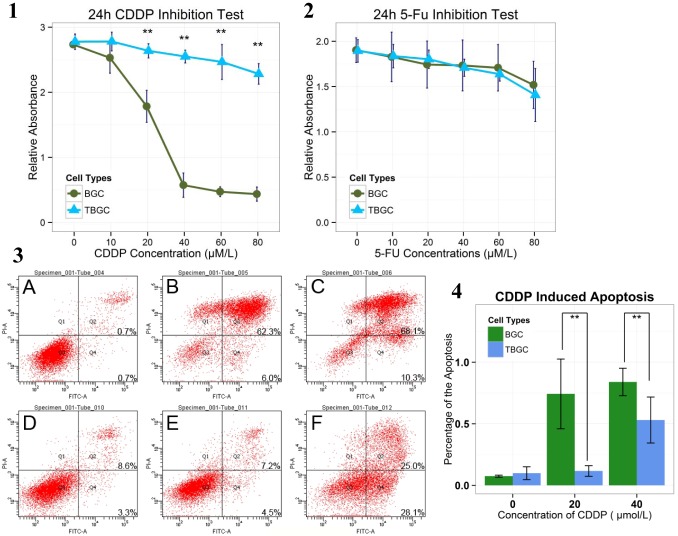
TBGCs exhibited cisplatin resistance.

Figure 3

.1. Twenty-four-hour line plot of the cisplatin-inhibition test. **p<0.01.
Figure 3

.2. Twenty-four-hour line plot of the 5-FU inhibition test.
Figure 3

.3. Flow cytometry was used to assess apoptosis in BGC and TBGC cells after exposure to different concentrations of cisplatin (20, 40 µM) for 24 hours. Cells were stained with Annexin V-FITC (marker of apoptosis) and propidium iodide (PI) (marker of dead cells).
Figure 3

.4. Bar plot of cisplatin-induced apoptosis in BGC-823 cells and TBGCs. Bar graph showing the percentage of apoptotic cells according to flow cytometry. **p<0.01 vs cells in the dimethyl sulfoxide (DMSO) control wells.